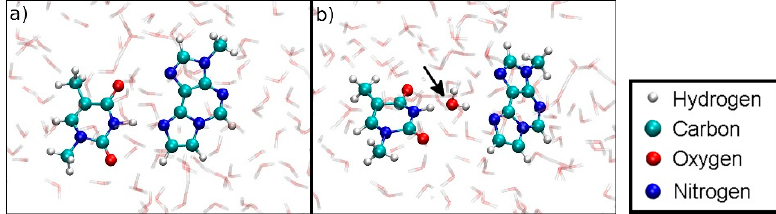
Figure 19. ( a ) Initial geometry at D ISO = 3.6 Å of the dissociation MD for the Hg(II)-free hydrogen-bonded base pair (structure 4 ). ( b ) Dissociation is favoured due to the involvement of a water molecule in hydrogen bonding, which is not possible within a DNA duplex.